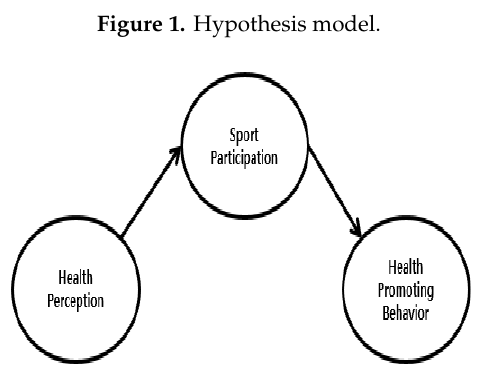
Figure 1. Hypothesis model.